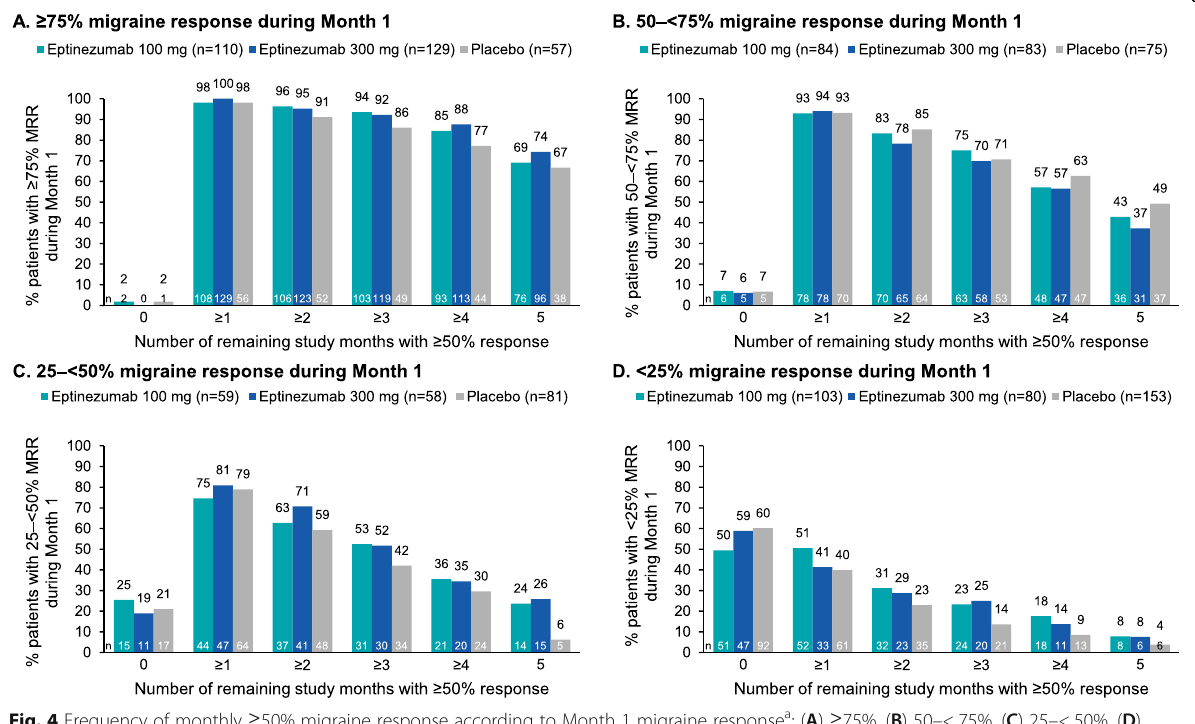
Fig. 4 Frequency of monthly ≥ 50% migraine response according to Month 1 migraine response a : ( A ) ≥ 75%, ( B ) 50 – < 75%, ( C ) 25 – < 50%, ( D ) < 25%. a Migraine response was defined as a percentage reduction in monthly migraine days. MRR, migraine responder